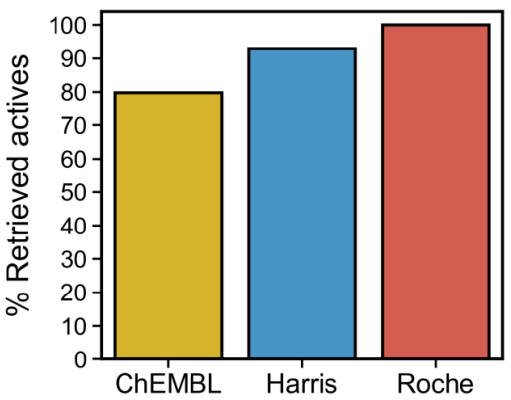
Figure 10. Performance of the 4-residue contact rule (LEU70, VAL75, ASP156, and LEU157) to filter actives from inactives from RIPK1 inhibitors datasets. The simultaneous occurrence of these four contacts is an adequate predictor of inhibition across the different subsets considered in this work (ChEMBL, Harris, and Roche subsets).